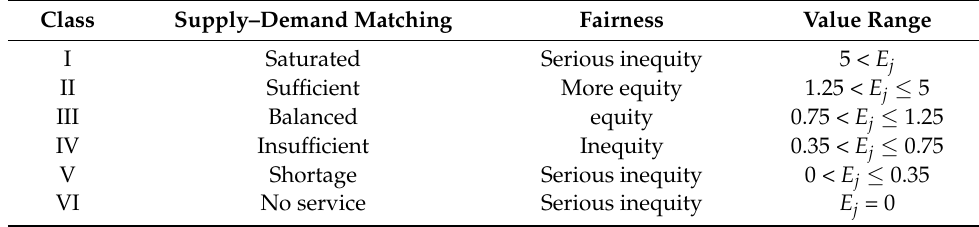
Table 3. Meaning of supply–demand matching and